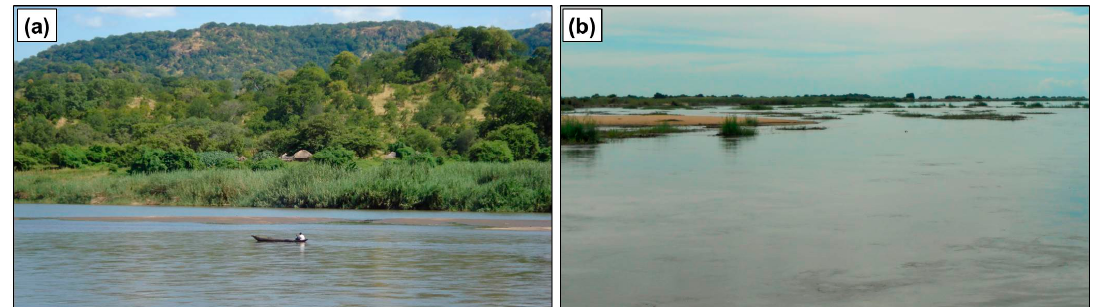
Figure 11. ( a ) Picture taken near the upstream boundary of the investigated area. ( b ) Picture taken near the downstream boundary of the investigated area. Typical morphological features of the lower Zambezi can be recognised.